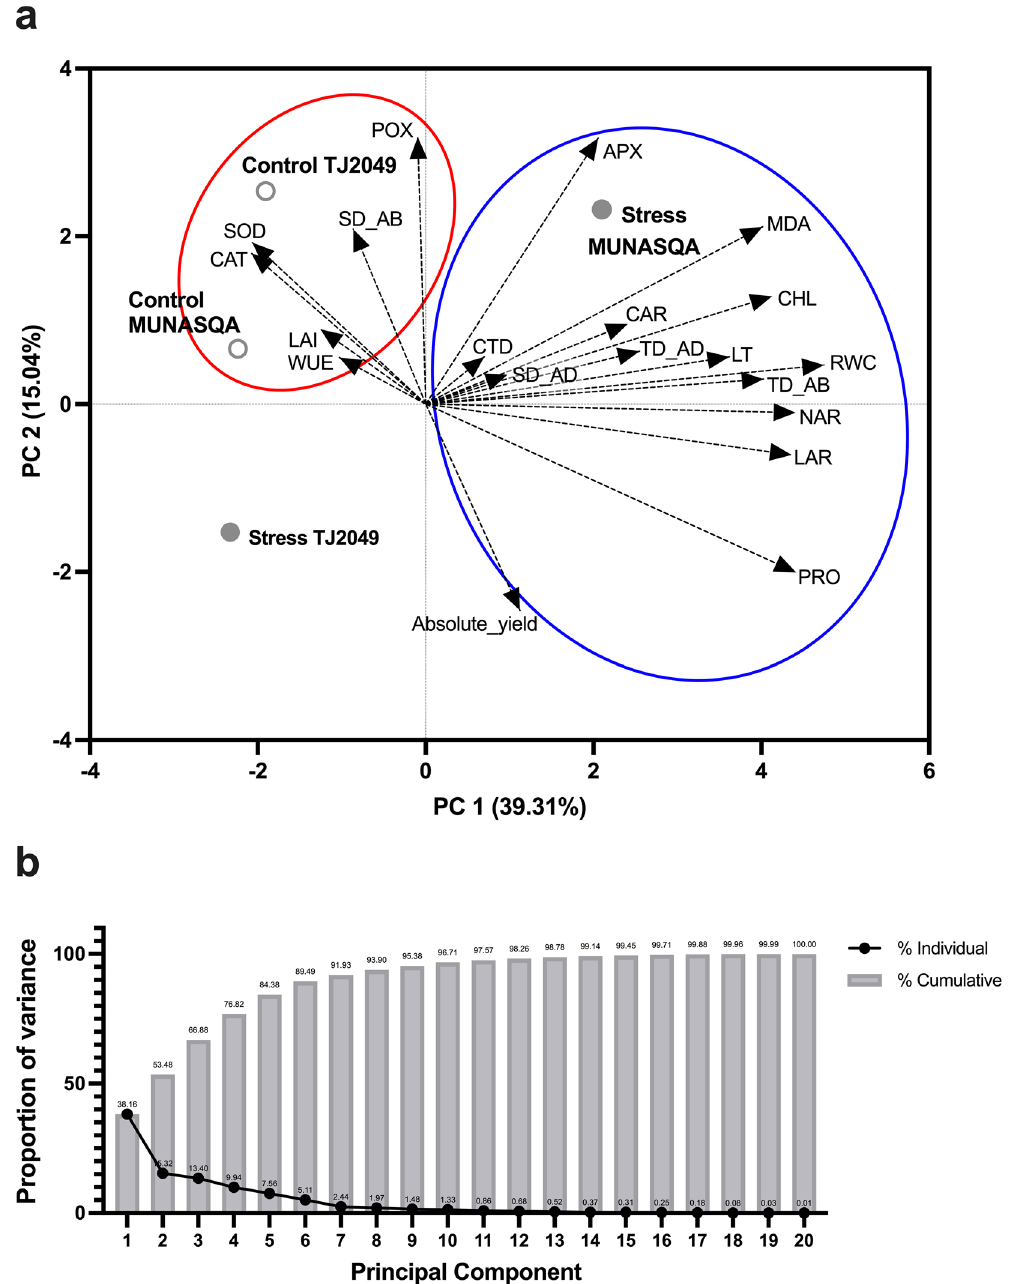
Figure 4. PCA for all the morphophysiological markers evaluated in MUNASQA and TJ2049